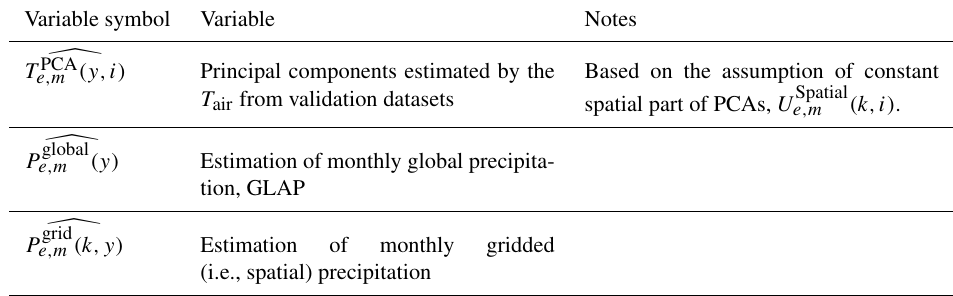
Table 3. List of variable symbols in the validation. Variable